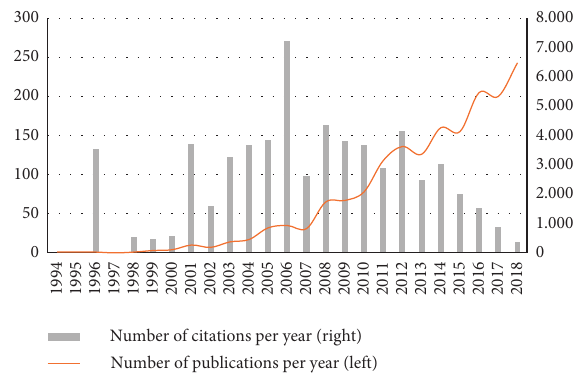
Figure 2: Number of citations and publications per year (1994–2018). Source: own elaboration with Web of Science and Scopus data (2018).